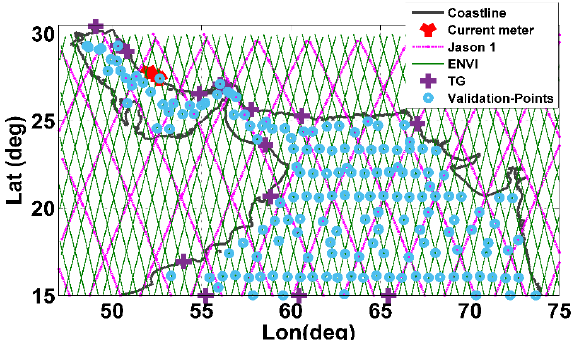
Figure 8. Two missions of satellite altimetry passes, coastal tide gauges, and current meter stations used in the study area.